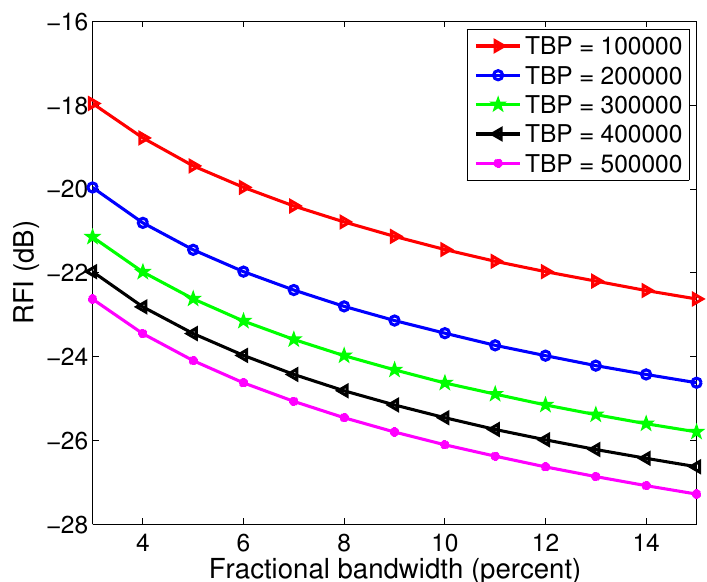
Figure 4. The radio frequency interference (RFI) between LFM and HFM with various fractional bandwidths and the time-bandwidth product